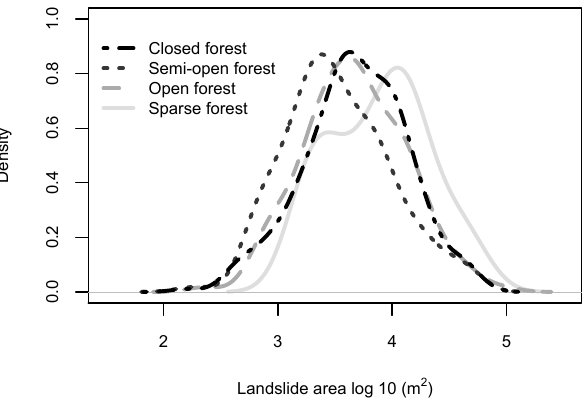
Figure 7. Empirical density function of landslide area for each for- est cover type using Gaussian kernel density